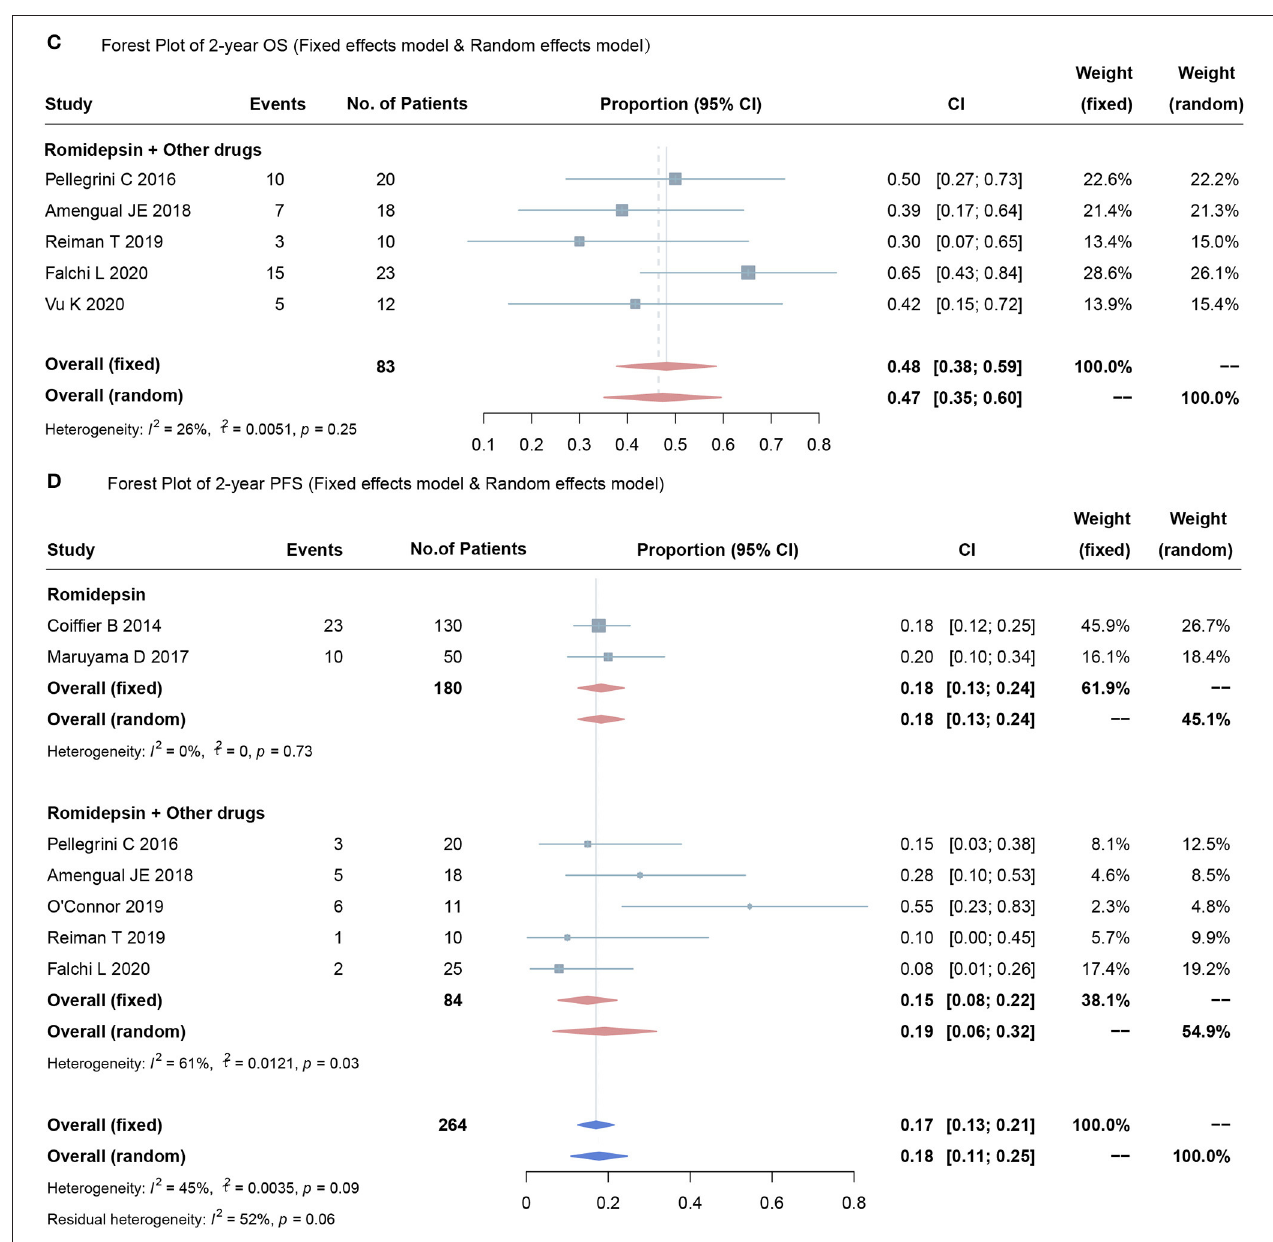
FIGURE 2 | Forest plots for over proportions of CR (A) , PR (B) , OS (C) , PFS (D) . Heterogeneity was assessed by using the I 2 statistic (0–25%, low likelihood; 26–75%, moderate likelihood; 76–100%, high likelihood), and the p value was used to test the heterogeneity of all studies ( p < 0.05 indicates likely variation across pooled estimates related to statistical